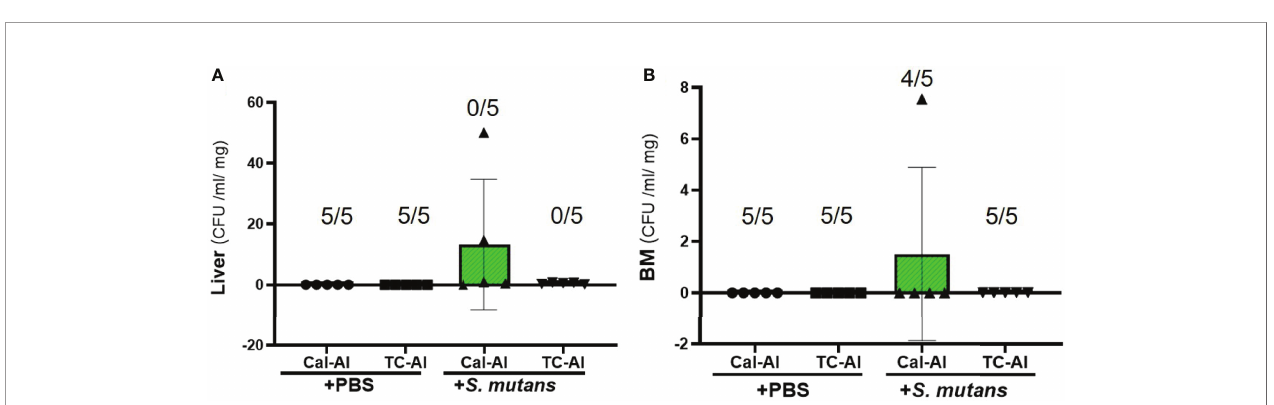
FIGURE 3 | Colony formation from the liver and bone marrow tissue on day 7 after intravenous injection of PBS or S. mutans inoculation. Comparison of the number of colonies derived from liver and bone marrow tissue after seven days of S. mutans inoculation. (A) The number of colonies derived from liver. (B) The number of colonies derived from bone marrow tissue. Cal-Al, mice received double injections of calcein and alizarin; TC-Al, mice received double injections of tetracycline and alizarin; +PBS, intravenously PBS-injected groups; +S. mutans , intravenously S. mutans -inoculated groups. The numerator and denominator numbers inside the bracket represent the numbers of the sample, which shows zero value and the number of all samples, respectively, i.e.: (5/5) means that 5 out of 5 have zero value. The variance of data was analyzed by the Levene test. The comparison between groups was analyzed by the Kruskal Wallis test and the Wilcoxon rank-sum test. Values are expressed as the mean ± SD.